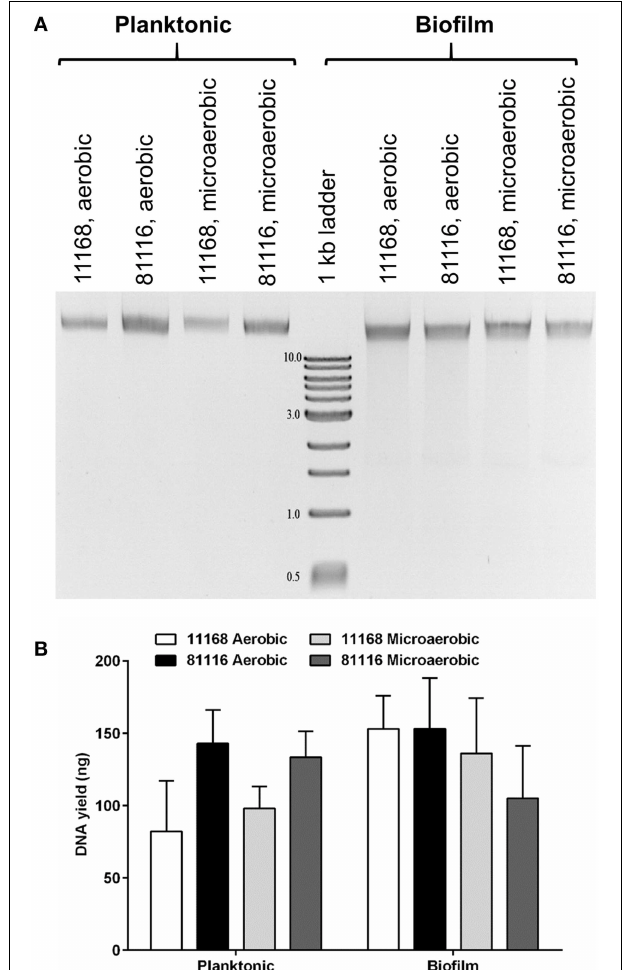
FIGURE 1 | Extracellular DNA is present in C. jejuni biofilms incubated in either aerobic and microaerobic conditions. (A) A representative agarose gel showing both planktonic and adhered cells recovered from 48h static cultures and loaded directly on a 0.9% agarose gel. Following gel electrophoresis, DNA was detected using ethidium bromide and UV light. Numbers next to 1kb marker bands indicate the size of the fragments in kilobases. (B) DNA was quantified ( n = 3 ) by comparing the intensity of the DNA bands with the 3kb fragment (125ng) using ImageJ. Error bars show standard deviation. There is no statistically significant difference in DNA yield between the strains or culture conditions as determined using